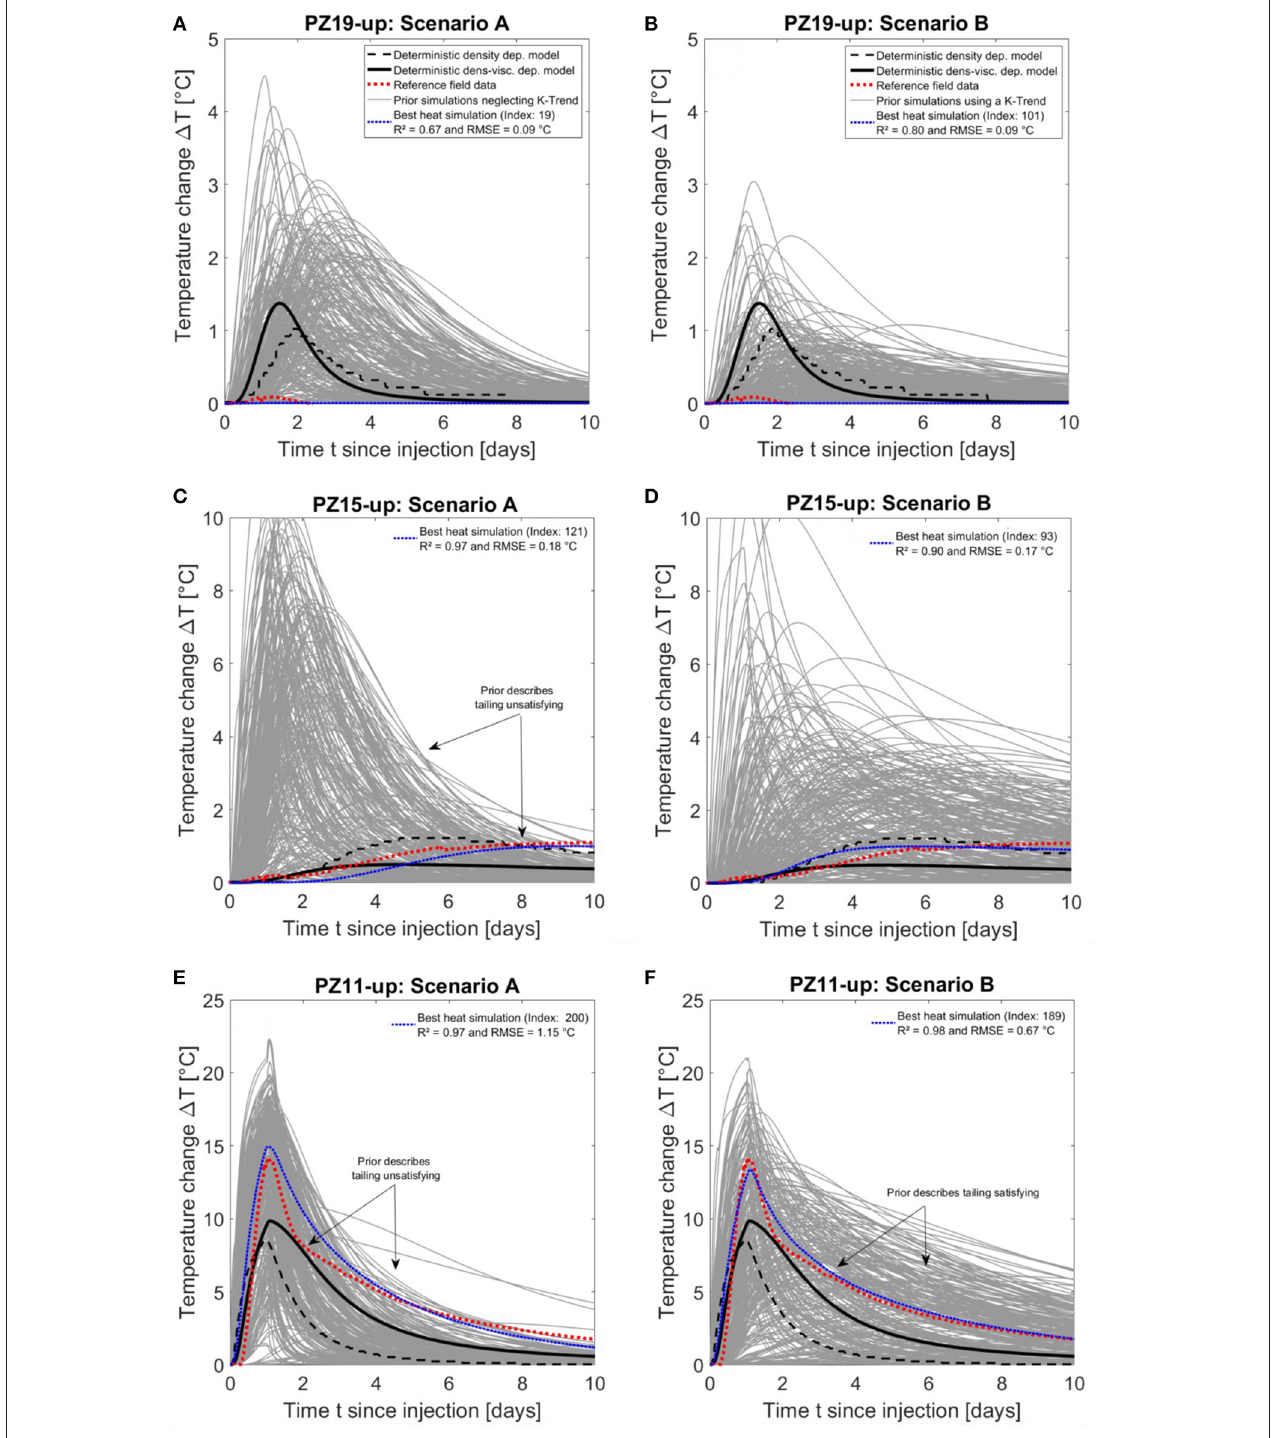
FIGURE 2 | Comparison between deterministic solution, real data and prior + best simulation for both random K-distribution scenarios for Pz19-up (Panel 3): (A) without K-trend (scenario A), (B) , with a downwards increasing K-trend (scenario B), for Pz15-up (Panel 2): (C) without K-trend, (D) with K-trend, and for Pz11-up (Panel 1): (E) without K-trend, (F) with K-trend (10 best heat simulations at each observation point are in Supplementary File ). The index of the best solution refers its number within the 250 simulations.